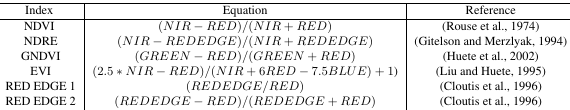
Table 1. Generated vegetation indices